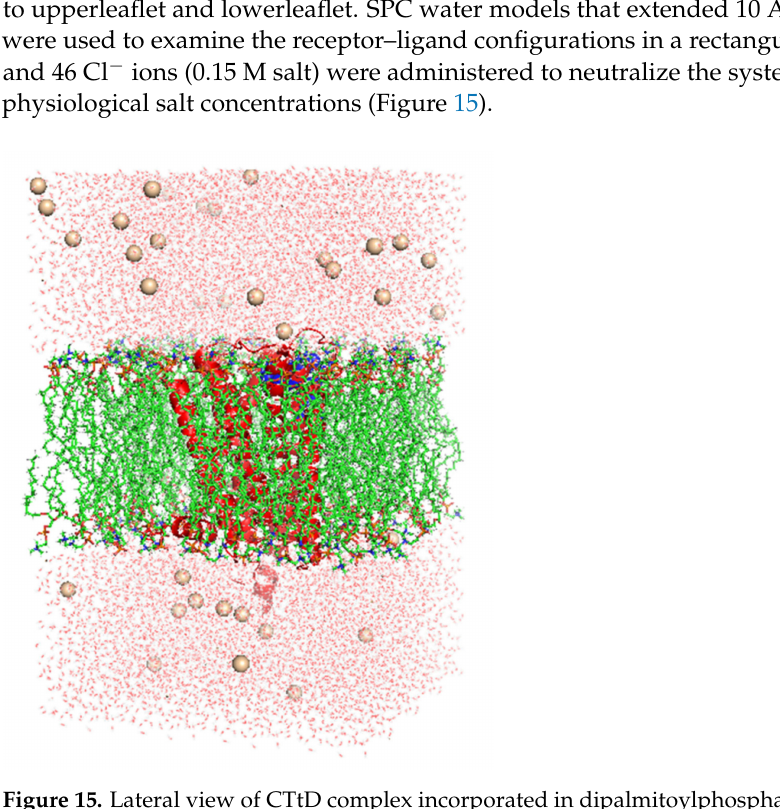
Figure 15. Lateral view of CTtD complex incorporated in dipalmitoylphosphatidylcholine (DPPC) membrane in a rectangular box solvated with water molecules and neutralized with 37 K + and 46 Cl − ions (0.15 M